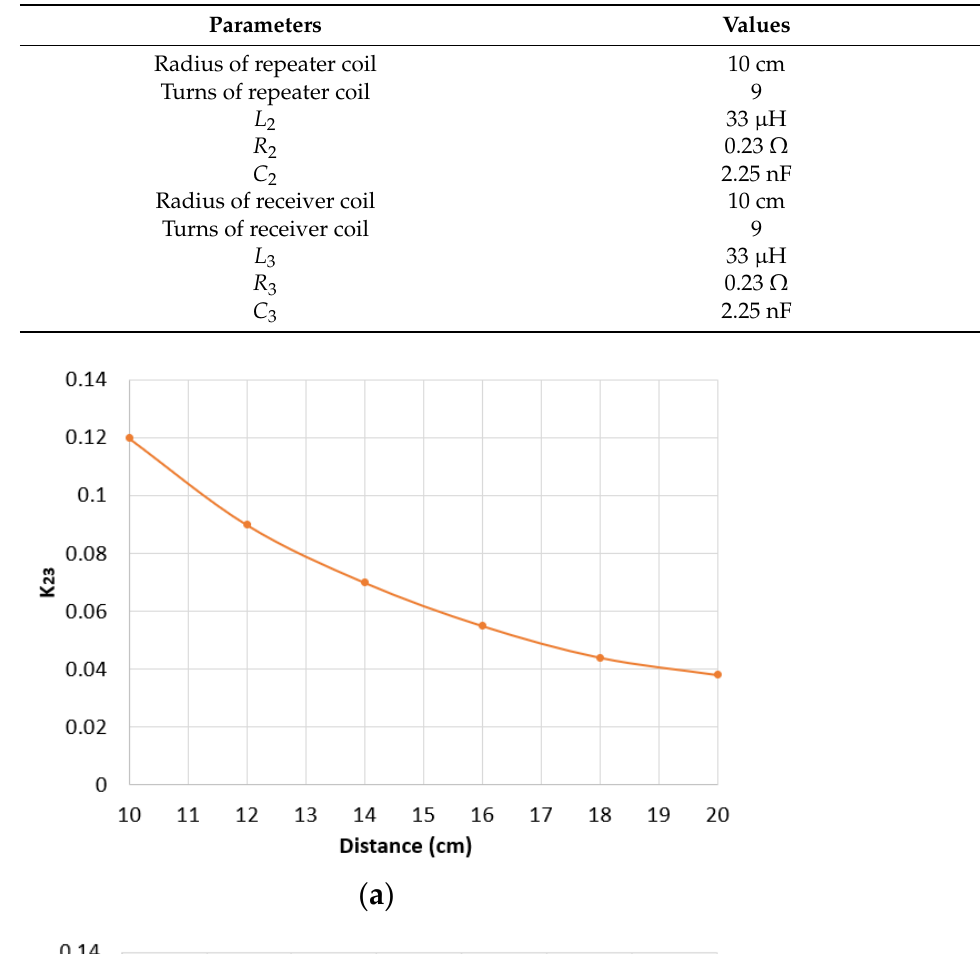
versus misalignment when distance is 10 (cid:2870)(cid:2871)